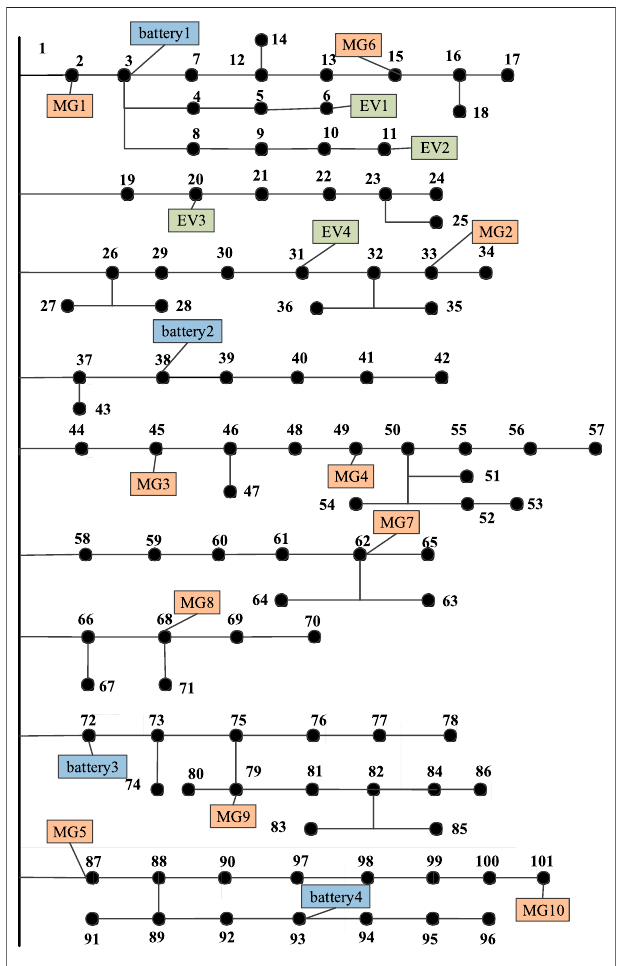
FIGURE 11 | The distribution of multi-stakeholder in the real 101-bus system.